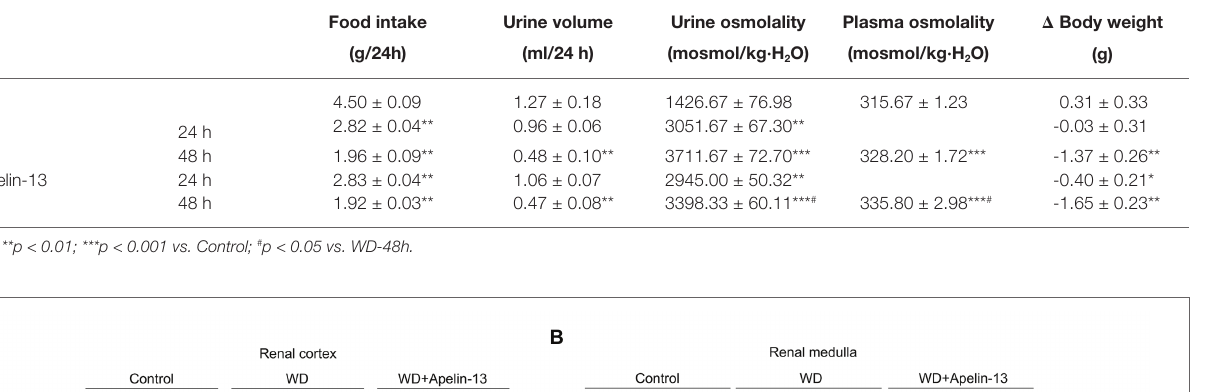
TABLE 1 | General physiological data in C57BL/6 mice.